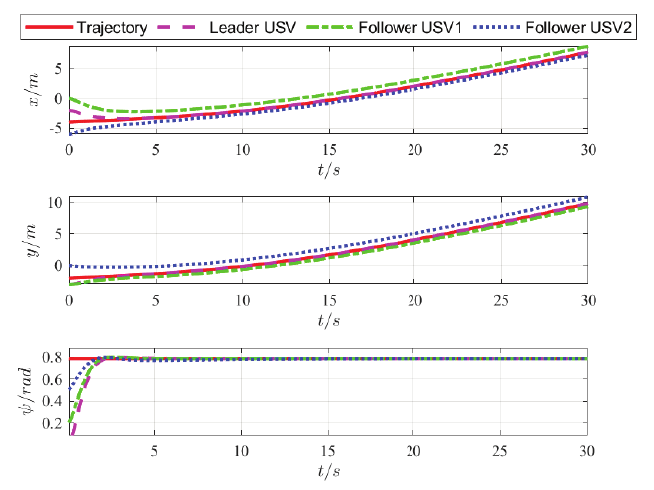
Figure 8. Position tracking using fixed-time